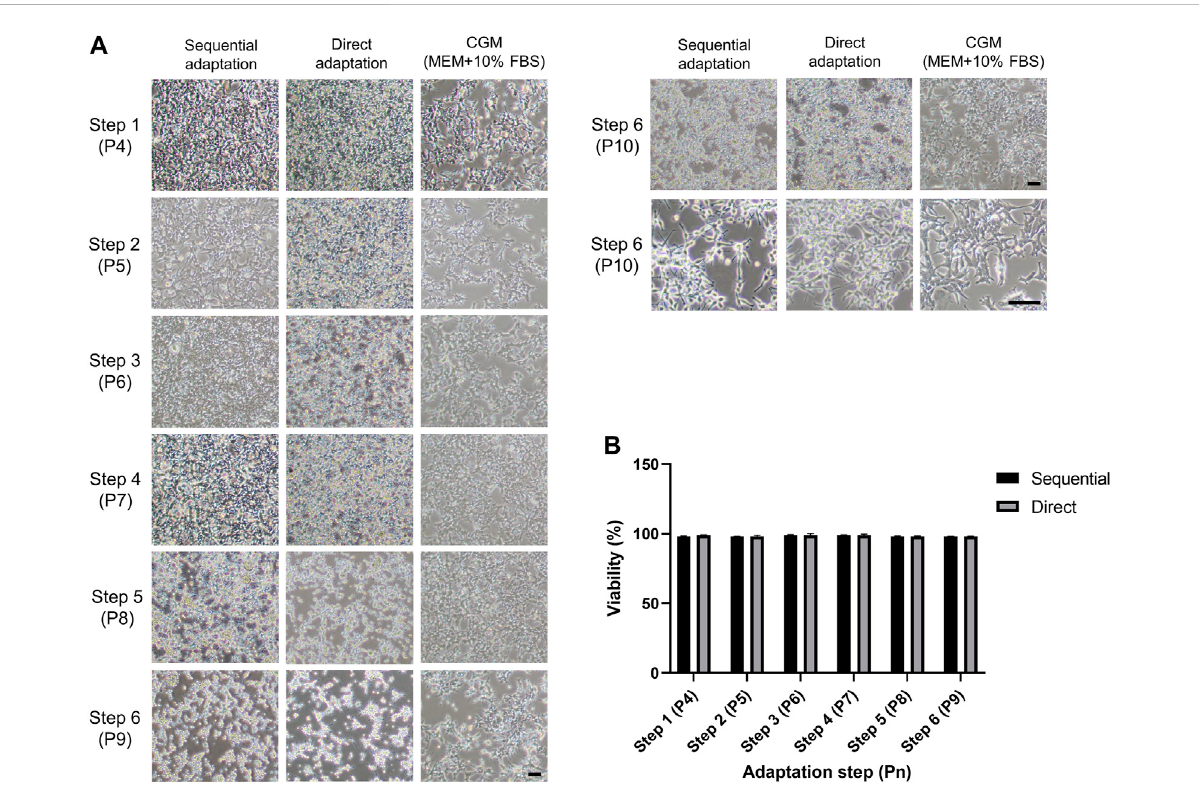
FIGURE 2 Morphology and cell viability of HEK293 cells during the adaptation procedures from step 1 to 6. (A) Phase-contrast images of each step in sequential and direct adaptations in SFM and in CGM. Left and right sides of the images showed the morphology of adherent cells cultivated in surface-treated and increased cell attachment fl ask, respectively. Scale bars indicate 100 µm. (B) Cell viability was measured during the entire adaptation steps. Pn indicates the passage number.